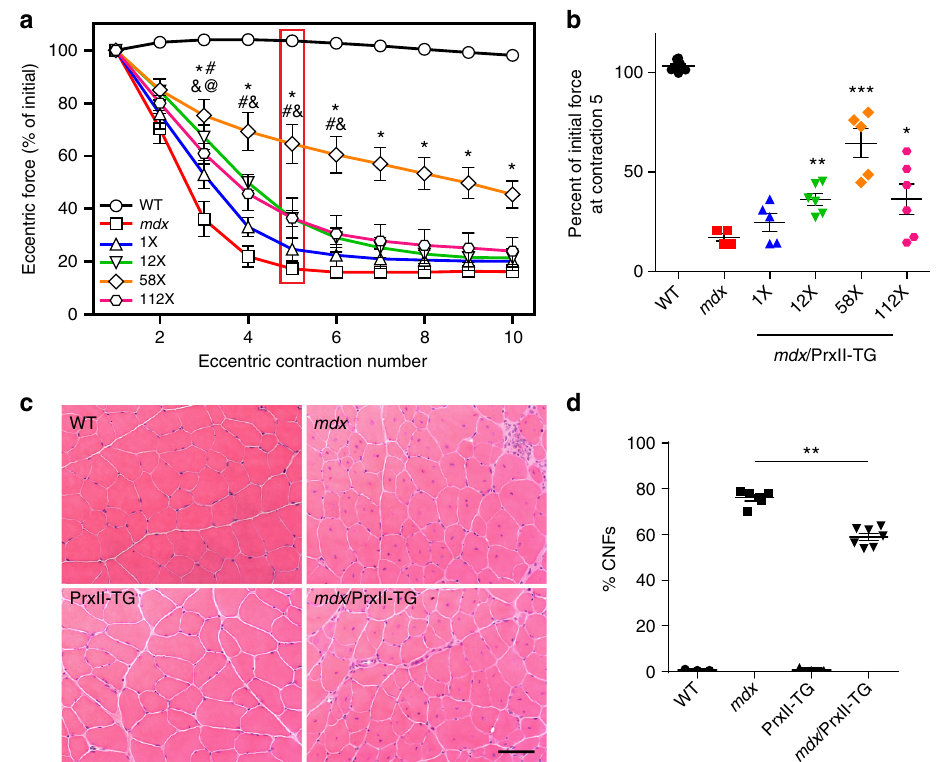
Fig. 5 Muscle-speci fi c peroxiredoxin-2 overexpression partially protects mdx muscle from eccentric contraction-induced force loss. a EDL muscles isolated from WT, mdx , and mdx /PrxII-TG lines expressing PrxII at 1-, 12-, 58-, and 112-fold relative to WT were subjected to 10 eccentric contractions and the forces measured expressed as a percentage of the force generated during the fi rst eccentric contraction; n = 8 for WT; n = 4 for mdx; n = 5 for 1× and 58×; n = 6 for 12× and 112×. @ 1× Signi fi cantly different from mdx ( P < 0.05), # 12× signi fi cantly different from mdx ( P < 0.05), *58× signi fi cantly different from mdx ( P < 0.001), & 112× signi fi cantly different from mdx ( P < 0.05); two-way ANOVA. b The force produced at contraction 5 for each line was presented as a percentage of initial force; n = same as in ( a ). * P < 0.05, ** P < 0.01, *** P < 0.001 compared to mdx ; one-way ANOVA. c Representative images of 10 µ m cryosections of TA from WT, mdx , PrxII-TG, and mdx /PrxII-TG (58×) stained with H&E. Scale bar: 50 µ m. d The 58-fold PrxII overexpression caused a small but signi fi cant decrease in the percentage of centrally nucleated fi bers (%CNFs) in mdx TA muscle; n = 3 for WT and PrxII-TG; n = 6 for mdx n; = 7 for mdx /PrxII-TG. ** P < 0.01 for mdx /PrxII-TG compared to mdx ; one-way ANOVA. Throughout, error bars represent means ±